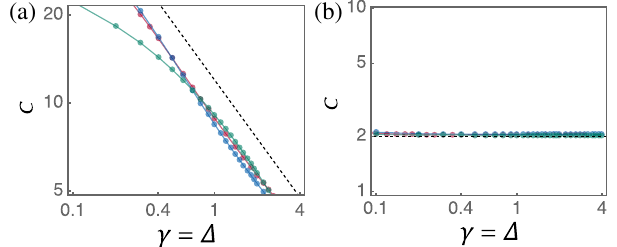
FIG. 16. Effective central charge c of the symplectic Hatano- Nelson model ( L ¼ 100 , J ¼ 1 . 0 ) at the critical point ( γ ¼ Δ ) under the (a) open boundary conditions and (b) periodic boun- dary conditions. For each γ ¼ Δ , the effective central charge c is obtained from the logarithmic scaling of the steady-state entan- glement entropy for the initial states in Eq. (24) (red dots), Eq. (C1) (blue dots), and Eq. (C2) (green dots). The black dashed lines are (a) c ∝ γ − 2 = 3 and (b) c ¼ 2